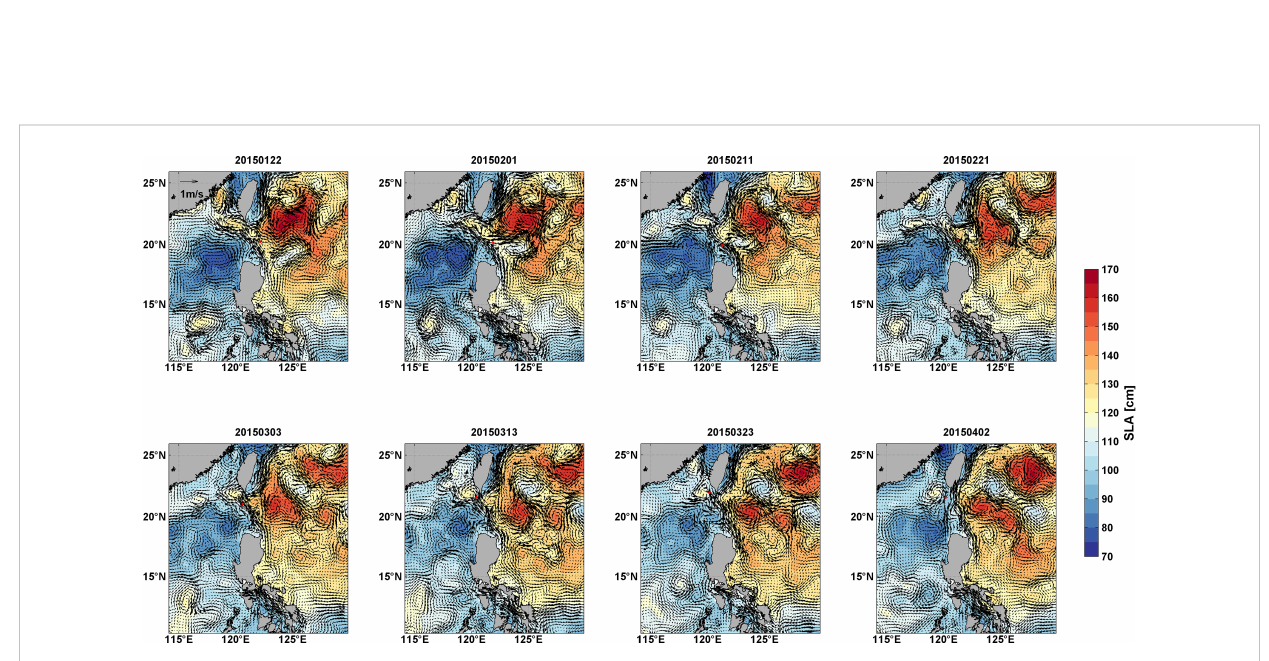
FIGURE 14 Distribution of SSH (shaded) and geostrophic sea surface current (vectors) from 22 Jan. 2015 to 2 Apr. 2015 with the CMEMS